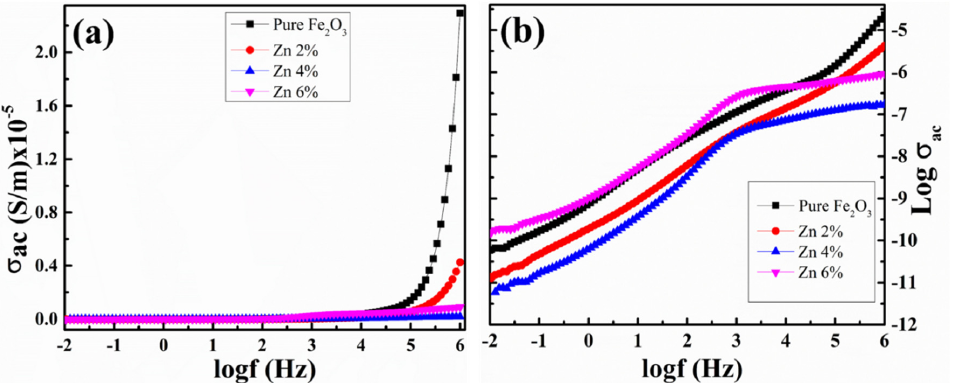
Figure 12. ( a ) Frequency dependency AC conductivity of pure Fe 2 O 3 , Zn 2%, Zn 4% and Zn 6% nanoparticles and ( b ) Linear plot of log σ ac versus logf.